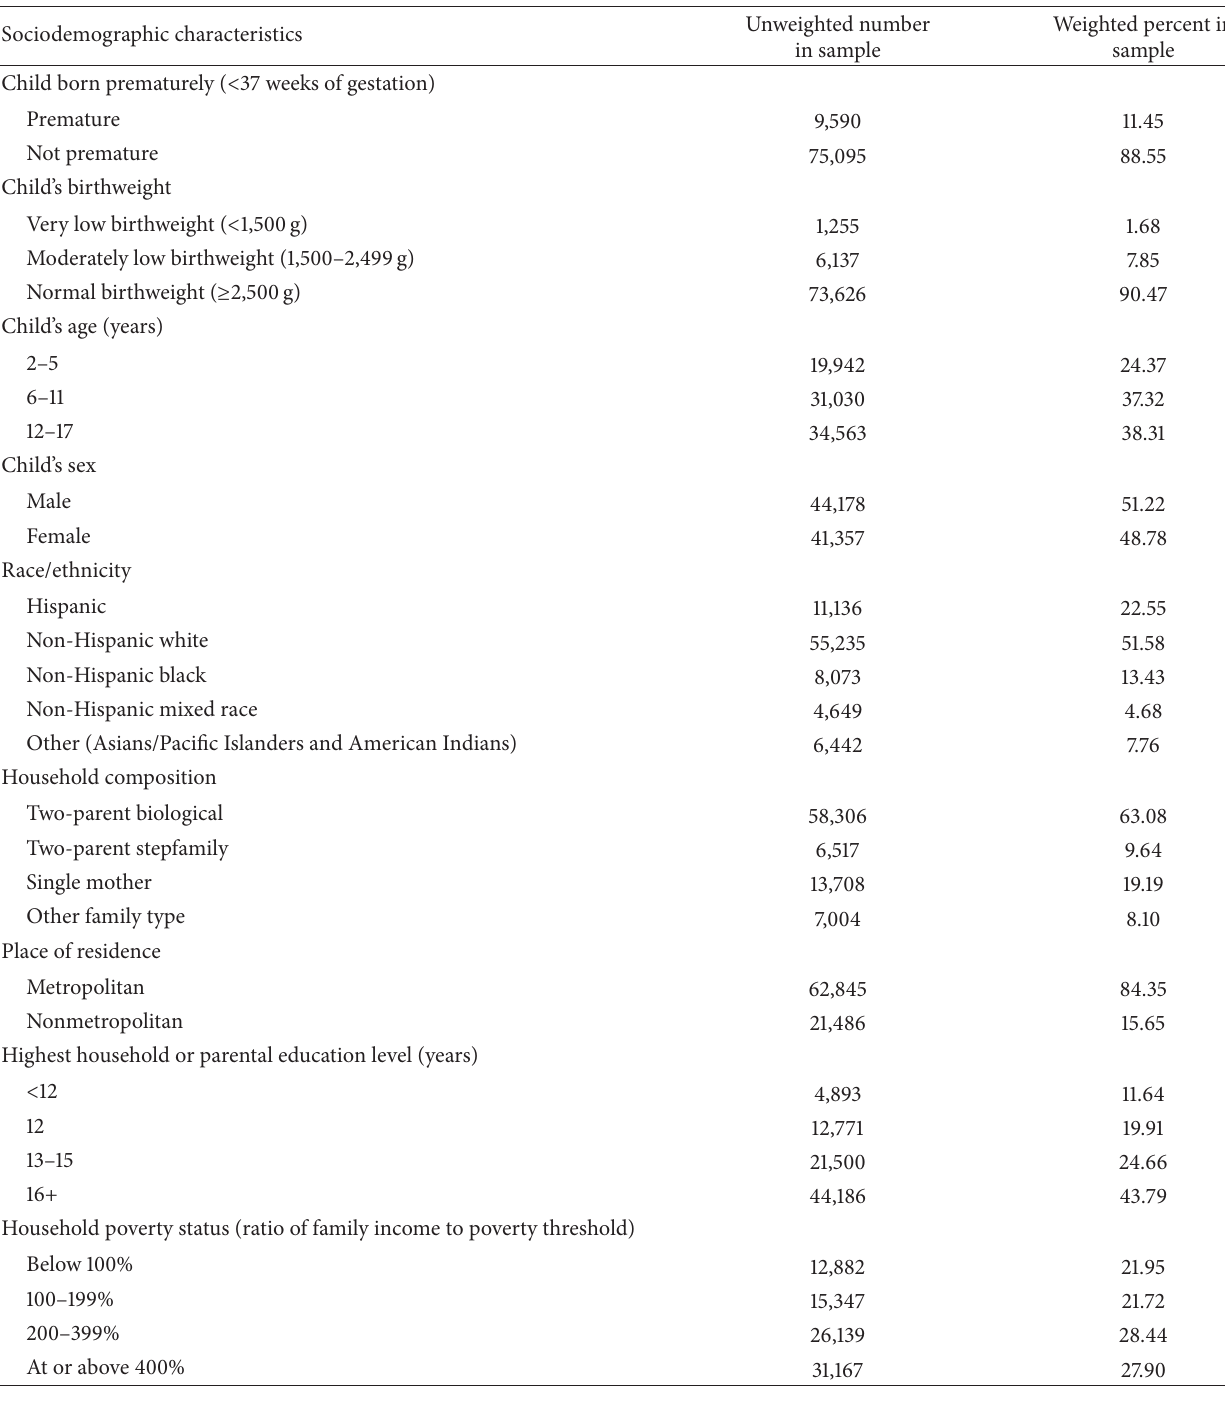
Table 2: Descriptive statistics of the sample for children aged 2–17 years, according to perinatal and sociodemographic characteristics: the 2011-2012 National Survey of Children’s Health ( 𝑁 =